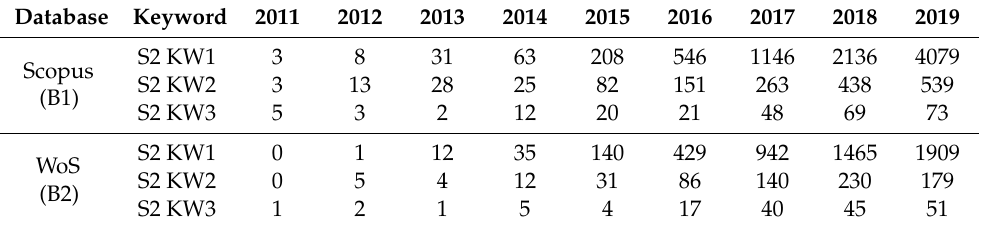
Figure 8. Number of publications for subject “Industry 4.0” over time (2011–2019). Table 6. Number of published scientific papers in the period from 2011 to 2019.